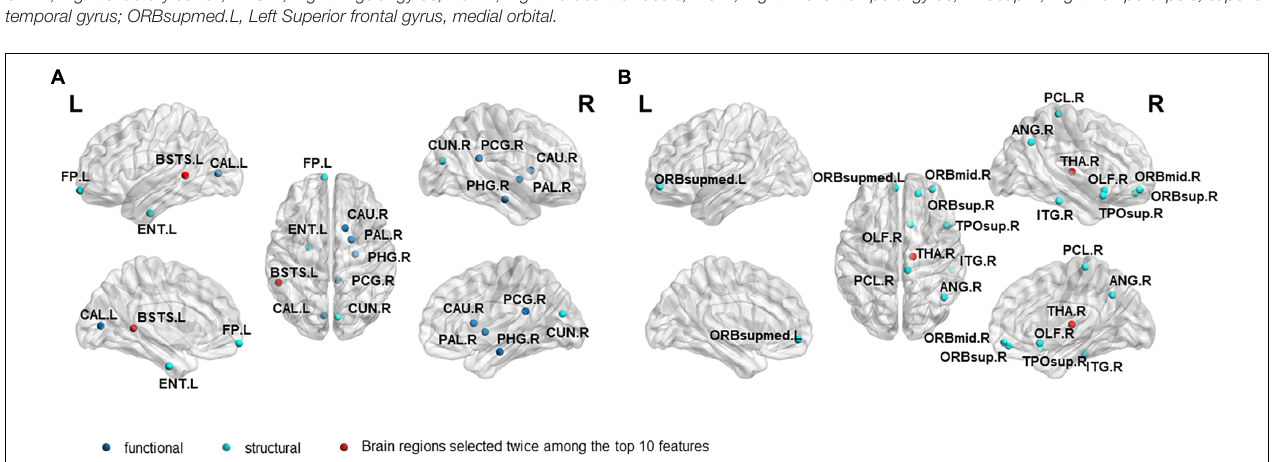
FIGURE 4 | The location and networks attribution of top 10 brain regions, listed in Tables 6 (A) , 7 (B) , which might be affected in early stage of